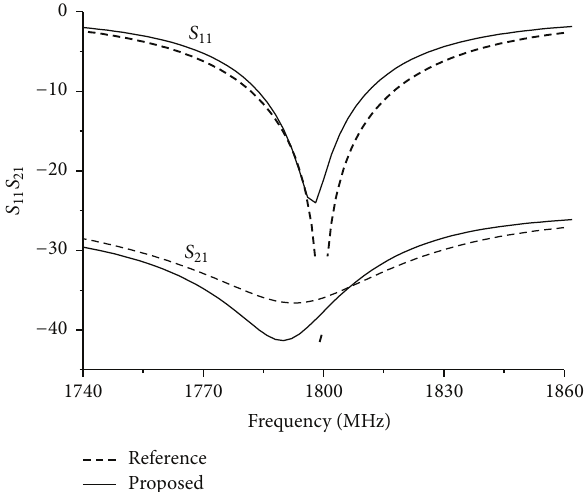
Figure 3: Simulated 𝑆 11 and 𝑆 21 of the proposed antenna and the typical one without any slots.